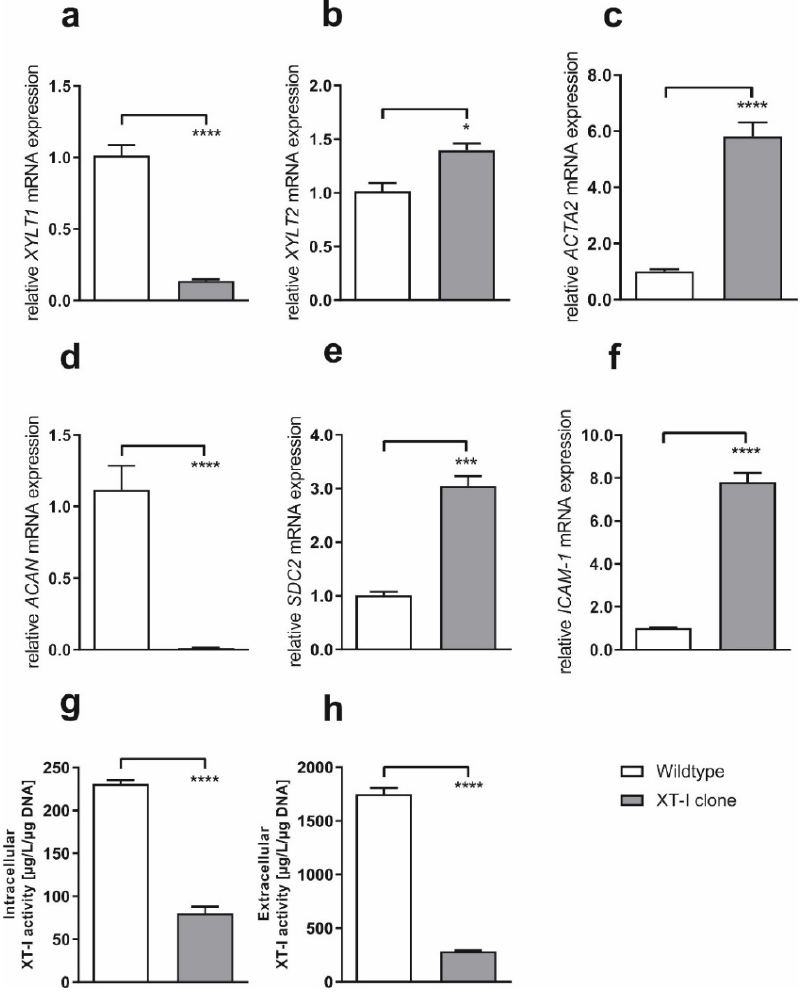
Figure 2. Relative basal mRNA expression levels of different ECM-related genes ( a – f ) and basal intra- and extracellular XT-I activities ( g , h ). Control- (n = 1) and XYLT1 − / − fibroblasts (n = 1) were seeded (50 cells/mm 2 ) and cultivated under standard cell-culture conditions. After 48 h of cultivation, total RNA was isolated and reverse transcribed. cDNA was used to determine relative mRNA gene expression levels of XYLT1 ( a ), XYLT2 ( b ), ACTA2 ( c ), ACAN ( d ), SDC2 ( e ) and ICAM-1 ( f ) by real-time PCR. Data were normalized to a normalization factor, determined by calculating the geometric mean of HPRT , GAPDH and β 2M mRNA expression levels, and expressed as a ratio to one cell line. Intra- and extracellular XT-I activities were determined after a cultivation-time of 72 h by mass-spectrometry and were normalized to DNA-concentrations. Values represent means ± SEM. * p < 0.05; *** p < 0.001; **** p < 0.0001.